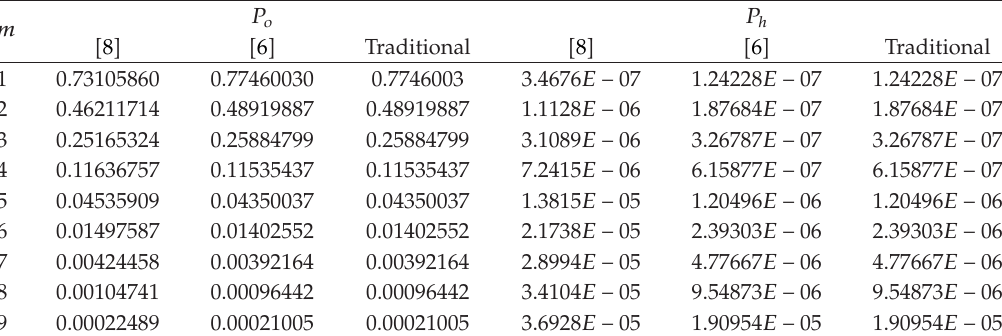
Table 3: Comparison of di ff erent algorithms for the case N (cid:8) 10, λ o (cid:8) λ h (cid:8) 5, μ o (cid:8) μ h (cid:8)